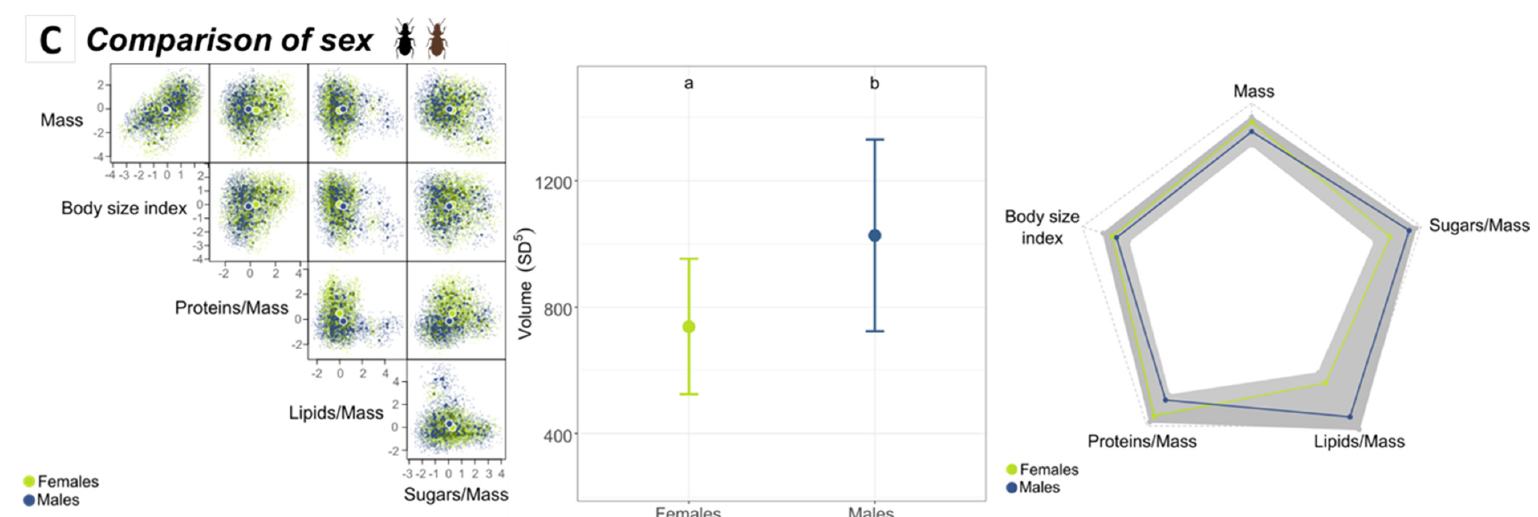
Figure 4. Hypervolumes based on five functional traits over five altitude levels at the species level: ( A )—Effect of altitude on the functional hypervolume of A. pacificum ; ( B )—Effect of morphotype (L: light; D: dark) on the functional hypervolume; ( C )—Effect of sex. The figures in the left panel represent the probabilistic hypervolume clouds. Colors correspond to the levels of the explanatory variables (e.g., altitude, morphotype, and/or sex), and larger points are the centroids of each cloud relative to its considered level. The different windows show the hypervolumes on a two-dimensional scale based on the corresponding trait axes mentioned beneath. The middle panel represents the Z -test results for the sizes of the hypervolume comparisons across the different levels of the explanatory variables. Error bars correspond to the standard deviation calculated from 100 bootstrapped hypervolumes with values resampled within each level. Letters indicate significant differences (Bonferroni-adjusted p -value < 0.05). The right panel shows the contributions of each trait to the sizes of the hypervolumes, such that each color is mapped to one level of the variable. The gray area corresponds to the confidence interval calculated from the bootstrapped hypervolumes for each trait.